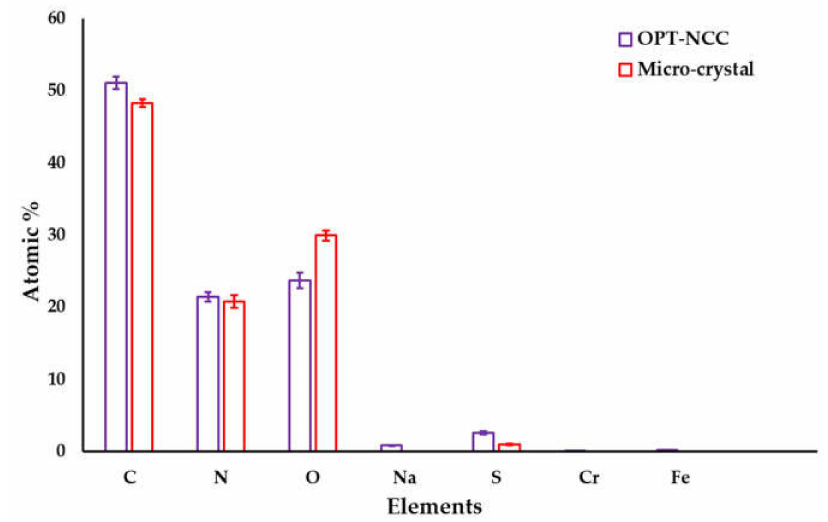
Figure 7. Elemental analysis of micro co-crystals (red) and OPT-NCC (violet).